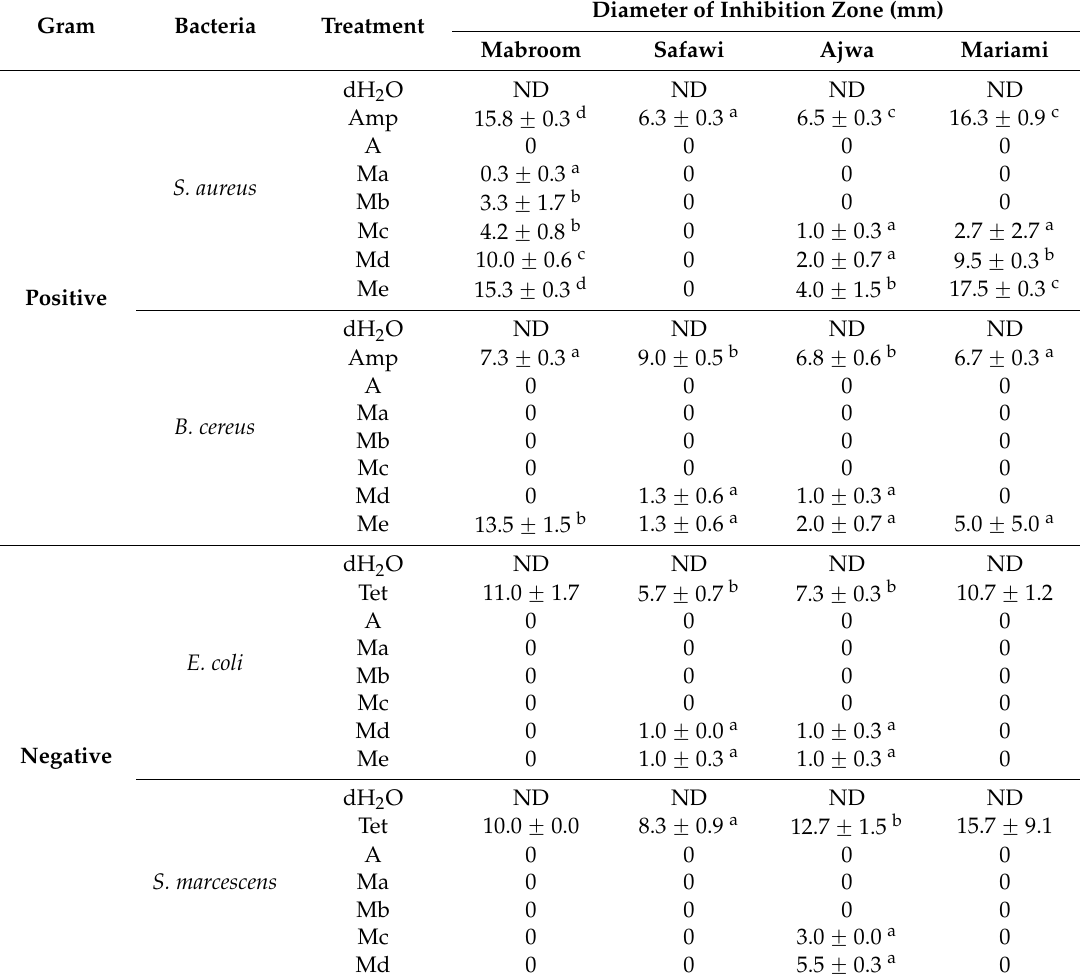
Table 4. Effect of different treatments on the diameter (mm) of the inhibition zone of different bacteria. Diameter of Inhibition Zone (mm) Gram Bacteria Treatment Mabroom Safawi Ajwa